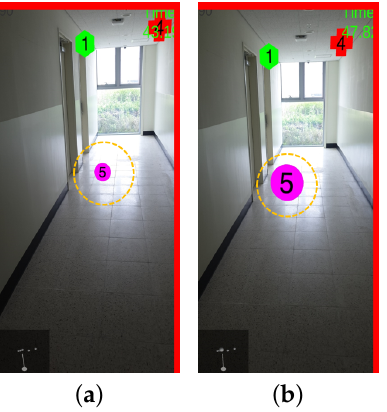
Figure 10. Example of enlarged animation screen. ( a ) Before enlarging the target object. ( b ) After enlarging the target object located at the center of the